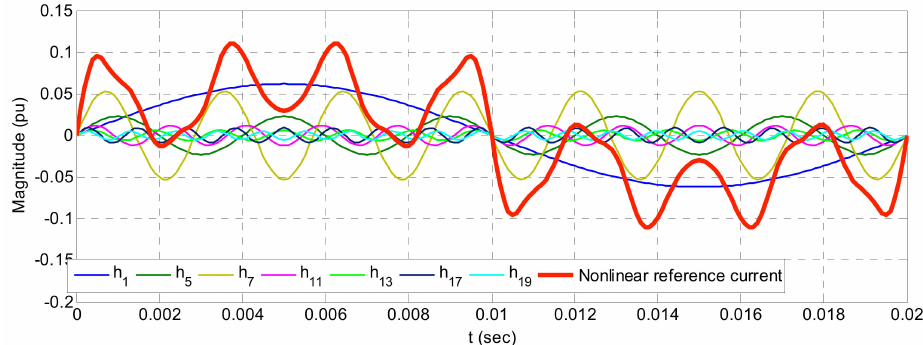
Figure 14. Fundamental harmonic and reference currents of ESS #2 in the peak period, (6 pm) in Case